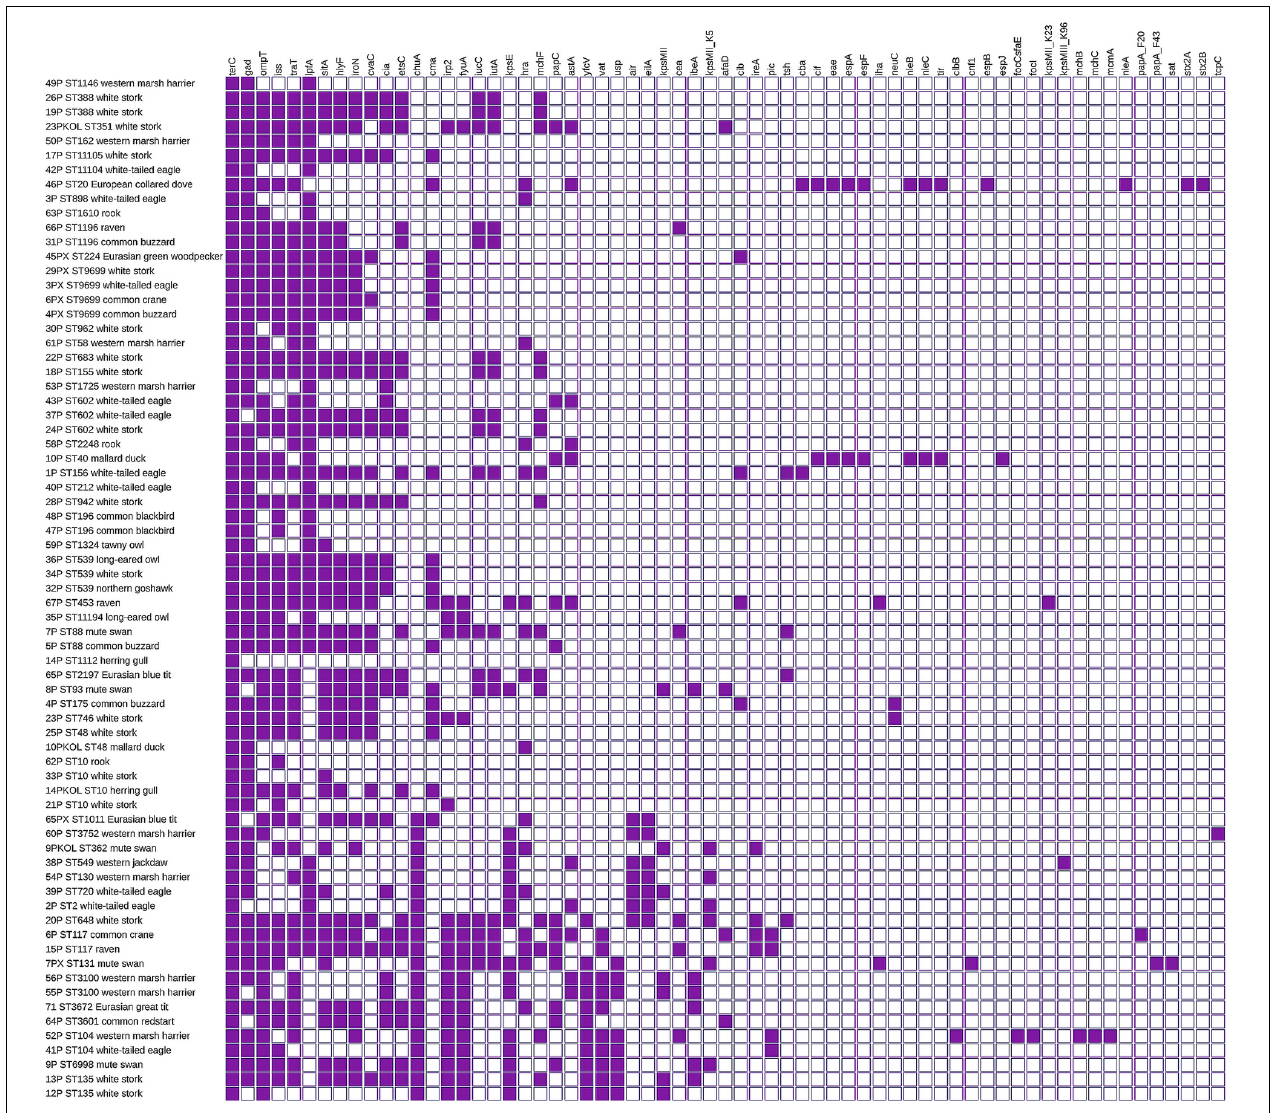
FIGURE 2 | Virulence of E. coli isolated from wild birds. Virulence factor by sequence type and bird’s species. Full and empty squares mean the presence or absence of virulence factors. The matrix was visualized with iTOL